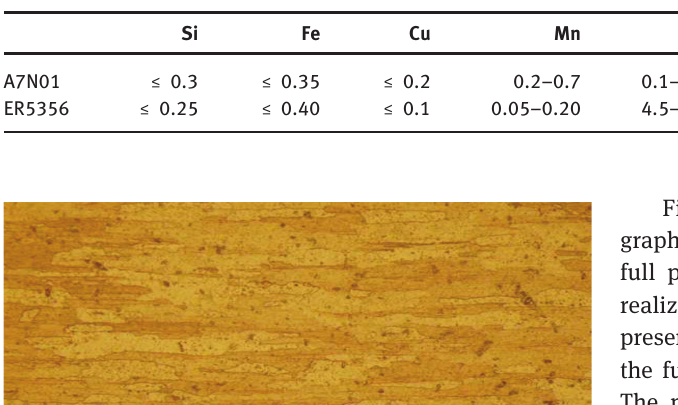
Table 1: Chemical compositions of the BM and the welding wire (wt.%).